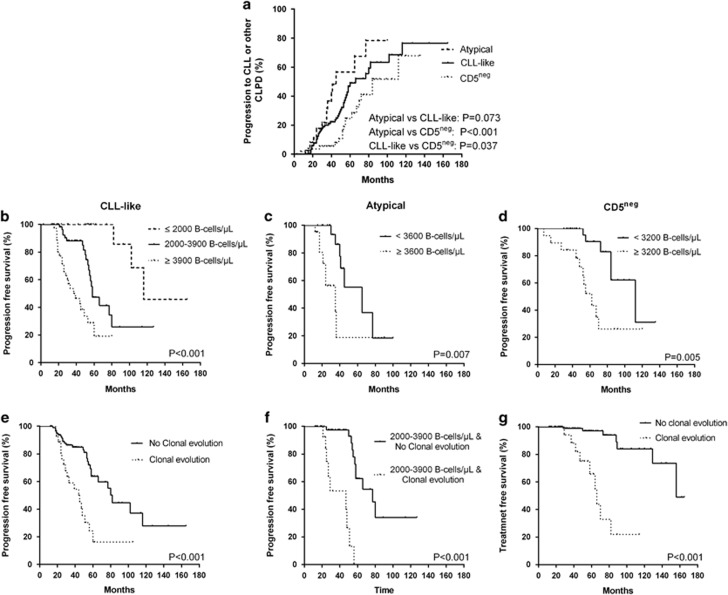
Risk of progression from MBL to CLL or other CLPDs. (a) Time-to-progression according to the phenotypic category. (b–d) Progression-free survival according to absolute B-cell count for CLL-like (b), atypical (c) and CD5neg (d) MBL. (e) Progression-free survival according to the presence of clonal evolution. (f) Progression-free survival for CLL-like MBL subjects with 2000–3900 B-cell count at initial diagnosis according to the presence or absence of clonal evolution. (g) Treatment-free survival for progressed cases according to the presence of clonal evolution at the preclinical MBL stage. CLPD, chronic lymphoproliferative disorder.